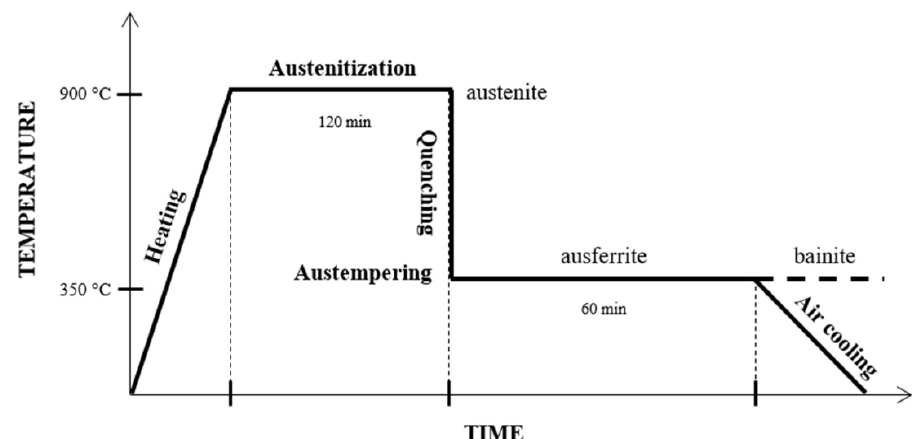
Figure 1. Schematic heat treatment process.